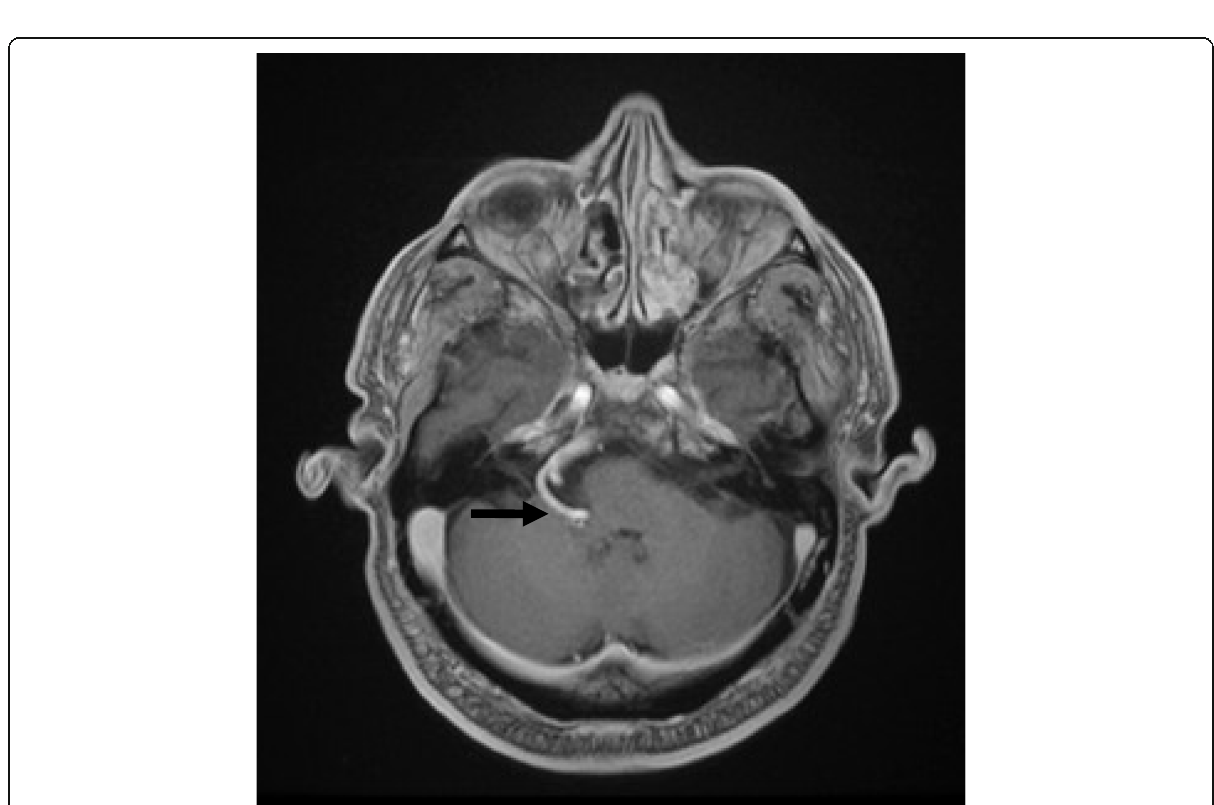
Fig. 2 Brain MRI of case (2) showed VBD compressing the MO